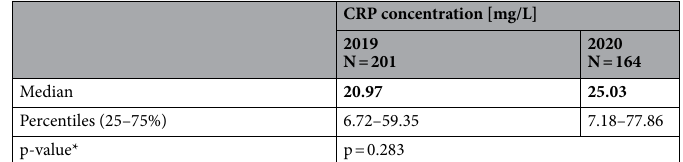
Table 2. CRP concentration in plasma of children treated because of an appendicitis in the years 2019 and 2020. *A p value < 0.05 is considered to show a significant difference between groups (according to the Mann– Whitney U